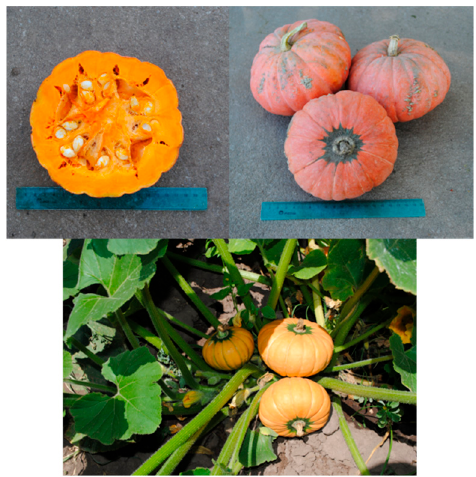
Figure 7. Fruits of Buttercup cultivar-group, left unripe fruit in plant, right , mature fruits, one upside-down showing the crown. Blue ruler 20 cm.